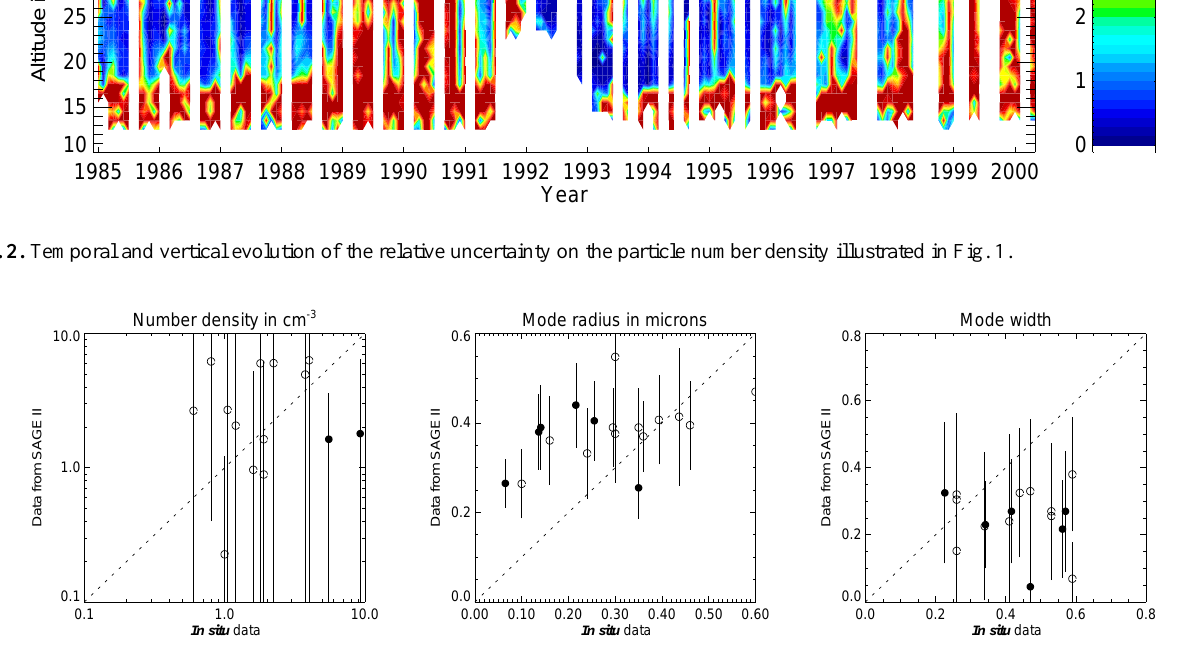
Fig. 3. Correlation diagrams between size distribution parameters obtained from SAGE II (this work) and values published by Deshler ( • ) and Pueschel ( ◦ )